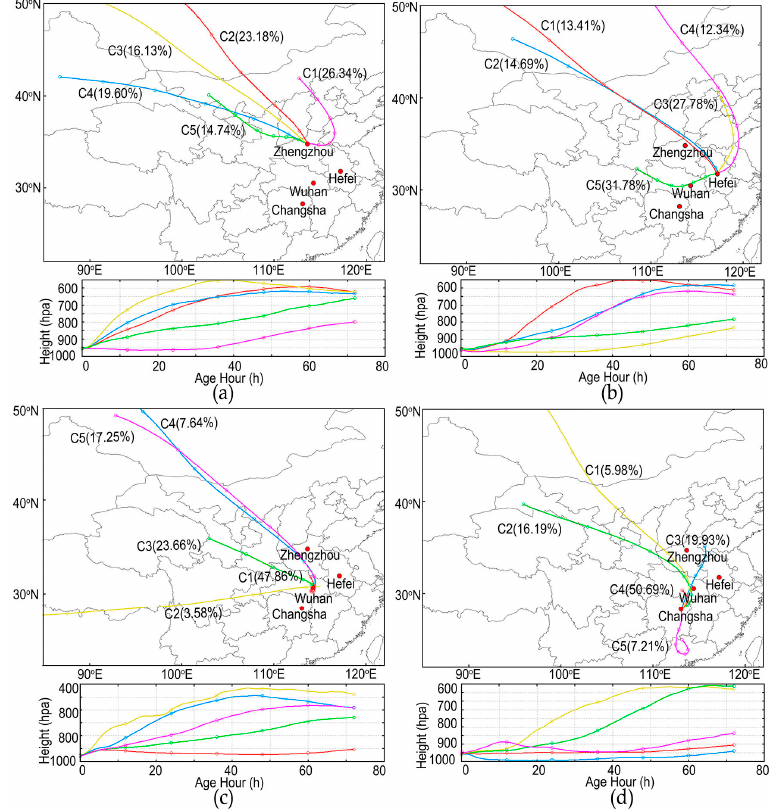
Figure 18. Cluster analysis of 72-h back trajectories at 500 m on horizontal and vertical for ( a ) Zhengzhou, ( b ) Hefei, ( c ) Wuhan, and ( d ) Changsha from 11 December 2014 to 26 February 2015.